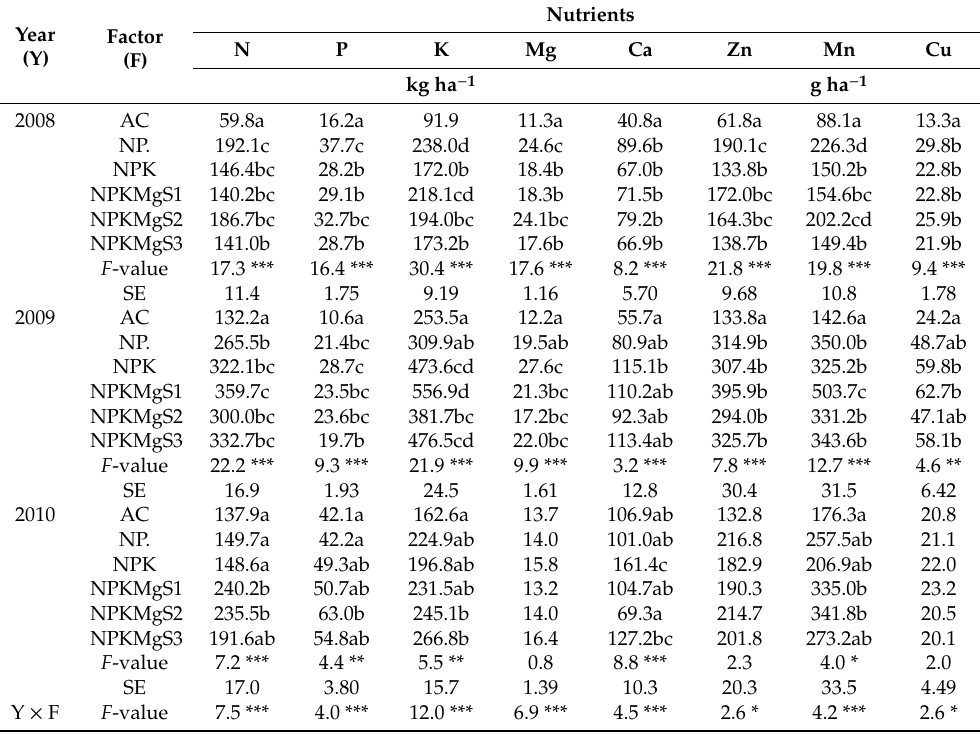
Table 3. Nutrient accumulation in oilseed rape at the beginning of